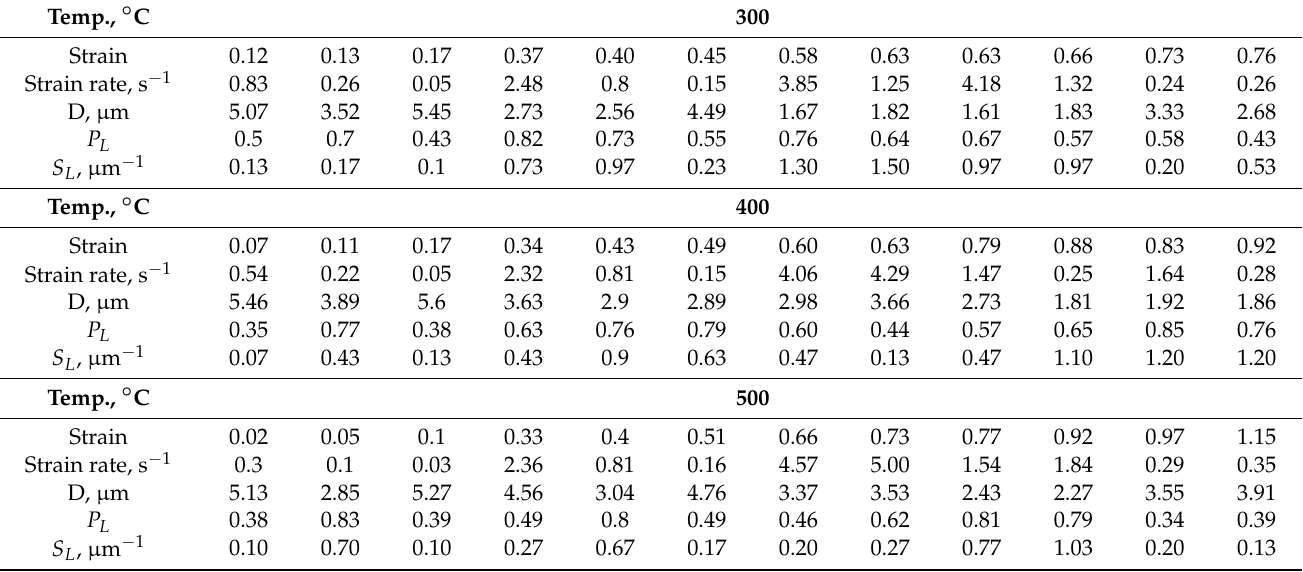
Figure 11. The effect of strain and strain rate on the density of low-angle boundaries depending on temperature, °C: ( a ) 300, ( b ) 400, ( c ) 500. The dependences are plotted from the results of the EBSD analysis of the microstructure. Table 3. Microstructure parameters of the AlMg6/10 % SiC MMC at temperatures of 300, 400, and 500 ◦ C.